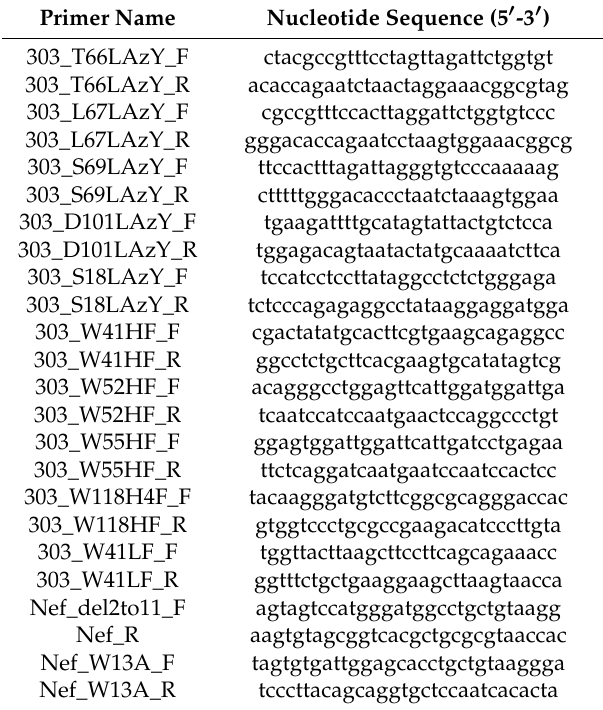
Table 1. Nucleotide sequences of primers used in the present